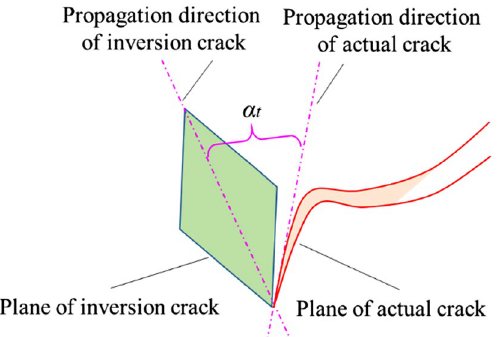
Figure 15. Schematic diagram of strike angle difference in crack expansion direction between AE moment tensor inversion results and actual measurement results.